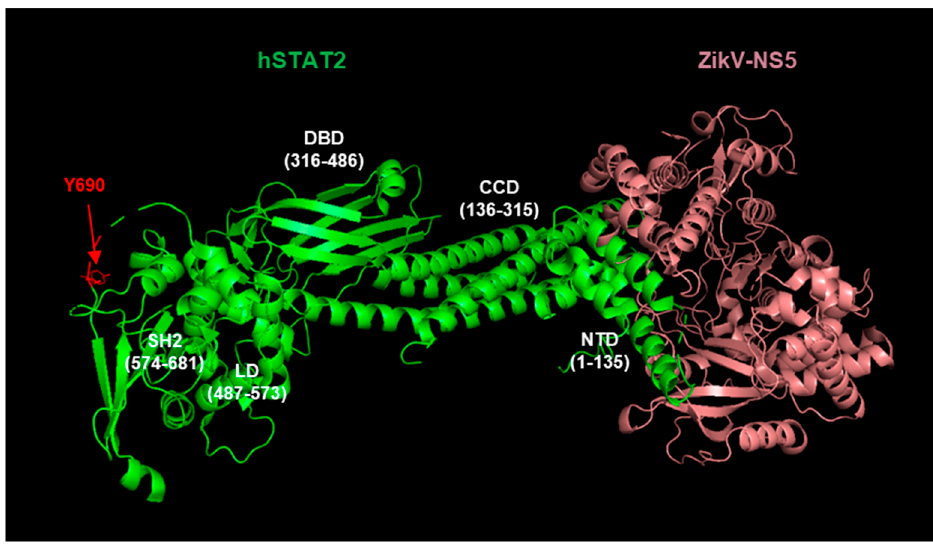
Figure 2. Cryo-EM structure (PDB 6WCZ) [75] of the complex of human STAT2 (green color) and ZIKV NS5 (salmon color). The various defined domains of STAT2 are indicated in white letters and residues numbers: N-terminal domain (NTD) that binds to the RdRP domain of NS5 (not labeled); coiled-coil domain (CCD) that binds within a cradle of the methyltransferase domain of NS5 (not labeled, behind NS5, away from viewer); DNA-binding domain (DBD), essential for the transcription function of STAT2; Src-homology domain 2 (SH2), involved in oligomerization with phospho-STATs, essential for the IFN pathway; the linker domain (LD) that connects the DBD to SH2 domain; lastly, the most abundantly phosphorylated site, Tyr690 (Y690, shown in red color), strategically located between the SH2 and the C-terminal transactivation domain.